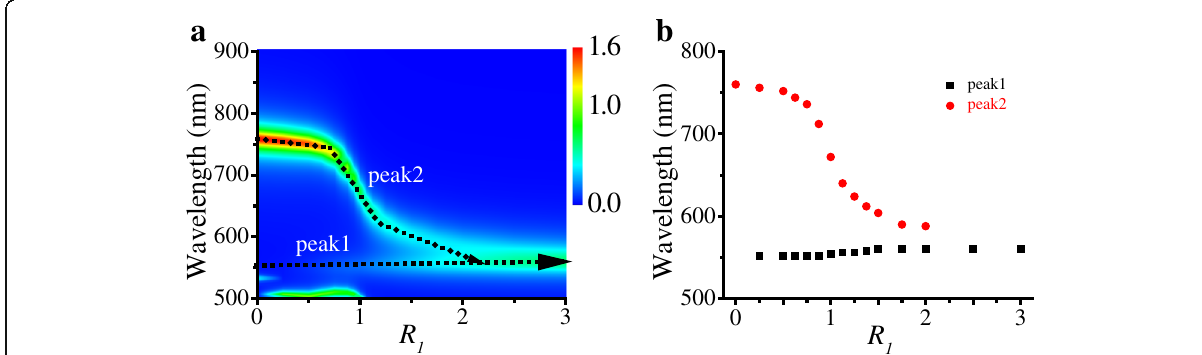
Fig. 5 ECS spectra of the Ag HNP dimer. a ECS intensity distribution map versus R 1 and wavelength. b Resonant wavelength spectra of the two